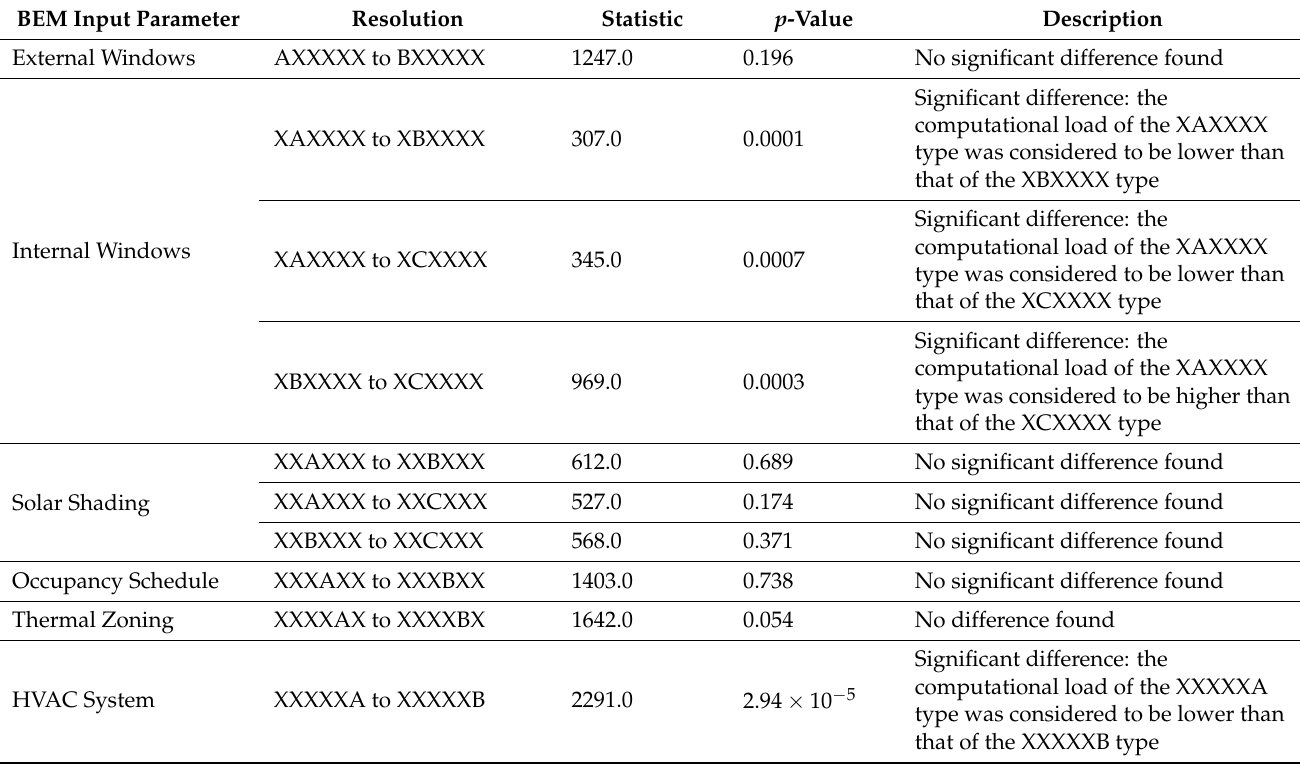
Table 7. The analysis of U-testing for the computational-load boxplot.